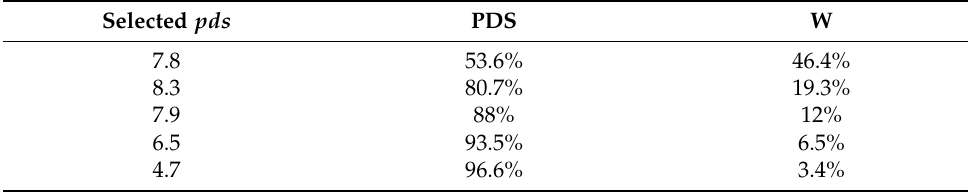
Table 8. Selected pds and percentage of served customers depending on the distance.